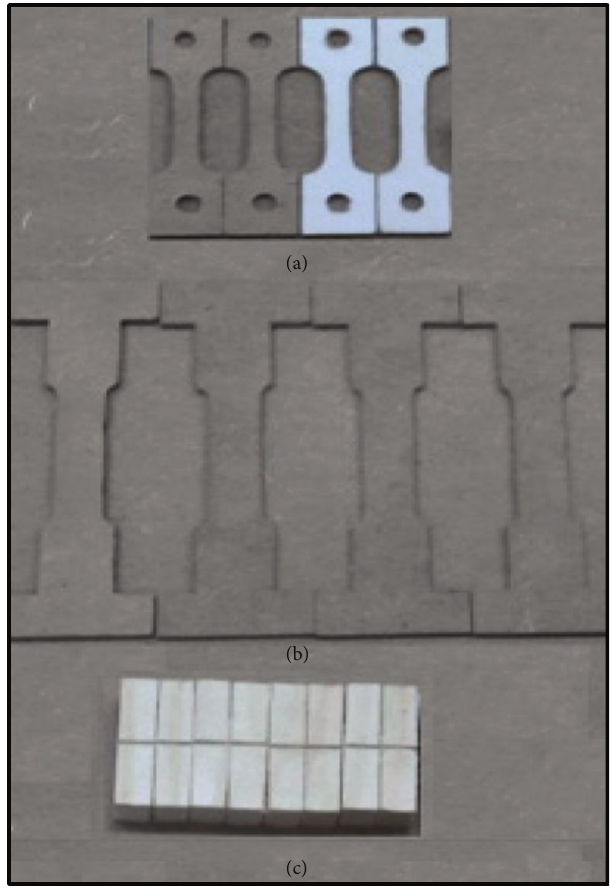
Figure 2: Patterns for (a) creep, (b) tensile, and (c) impact